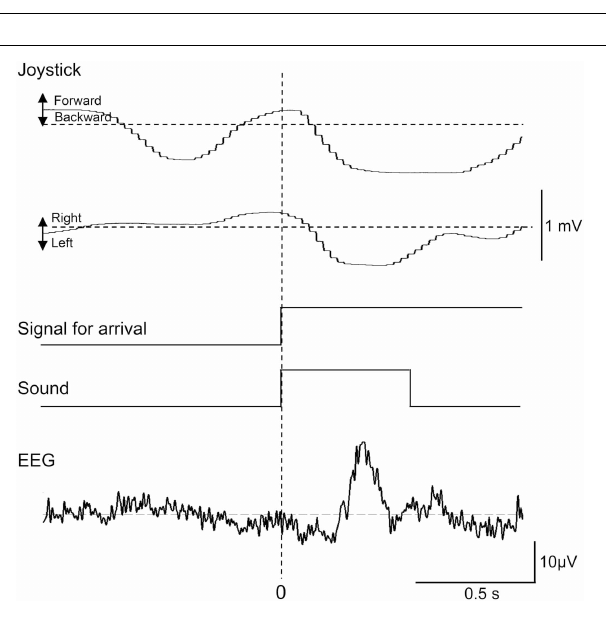
FIGURE 2 | Effect of eliminating the guiding green path on the duration spent on the virtual navigation task. Asterisks indicate significant differences ( P < 0 . 05).